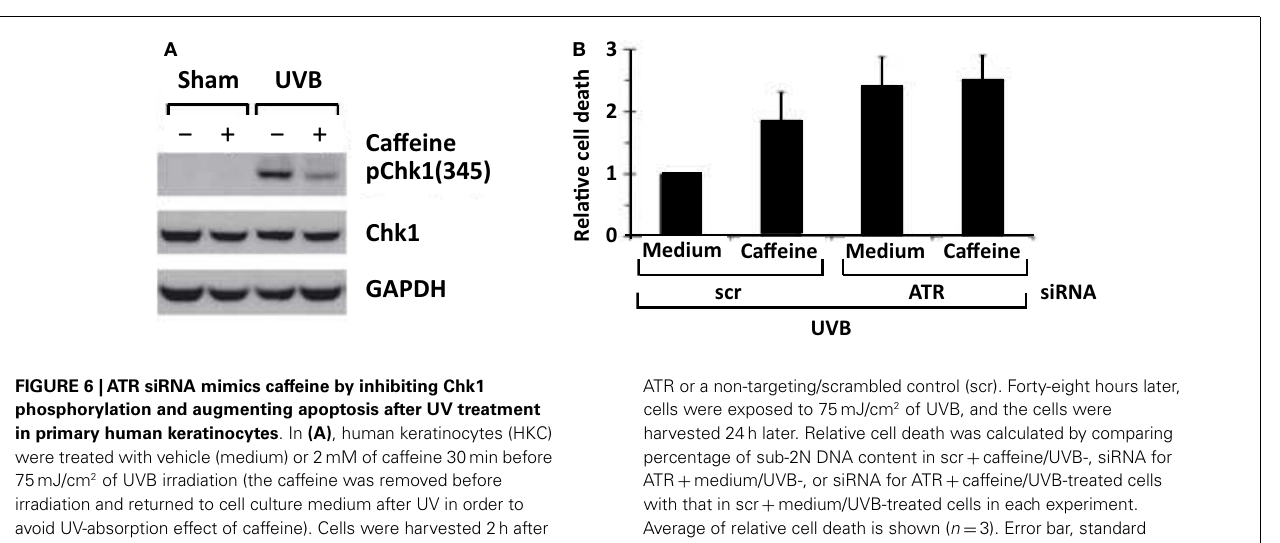
FIGURE 6 |ATR siRNA mimics caffeine by inhibiting Chk1 phosphorylation and augmenting apoptosis after UV treatment in primary human keratinocytes . In (A) , human keratinocytes (HKC) were treated with vehicle (medium) or 2mM of caffeine 30min before 75mJ/cm 2 of UVB irradiation (the caffeine was removed before irradiation and returned to cell culture medium after UV in order to avoid UV-absorption effect of caffeine). Cells were harvested 2h after UVB irradiation. In (B) , HKC were electroporated with siRNA against